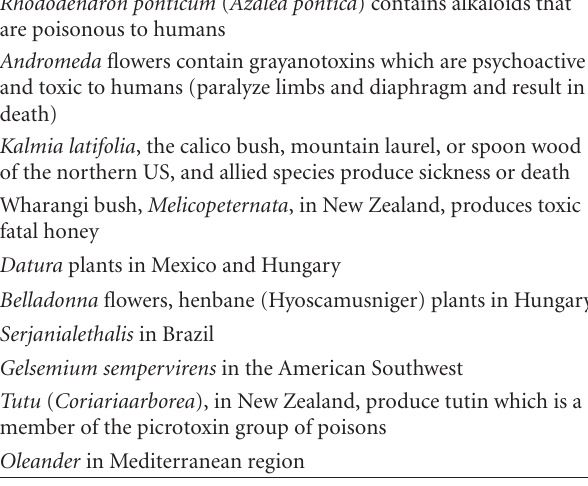
Table 2: Names of some plants whose nectar gives rise to toxic